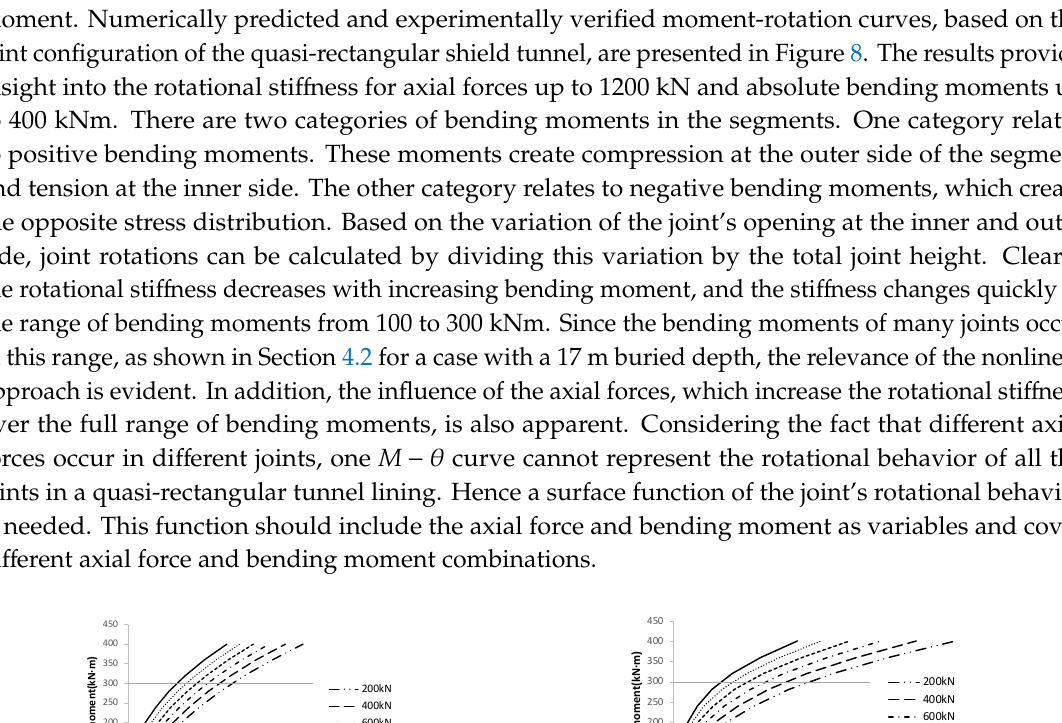
( b ) Figure 7. Joint experiments: ( a ) bending moment resistance experiment; ( b ) shear resistance experiment. 2.3.2. Rotational Stiffness As mentioned previously, full-scale bending moment resistance experiments on longitudinal